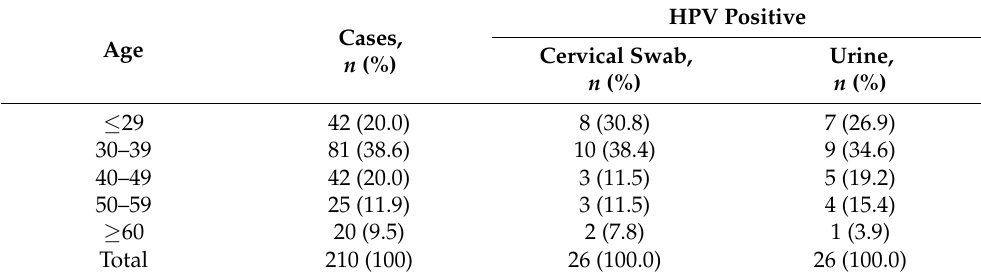
Table 2. Comparison of HPV positive rate by age between cervical and urine samples.